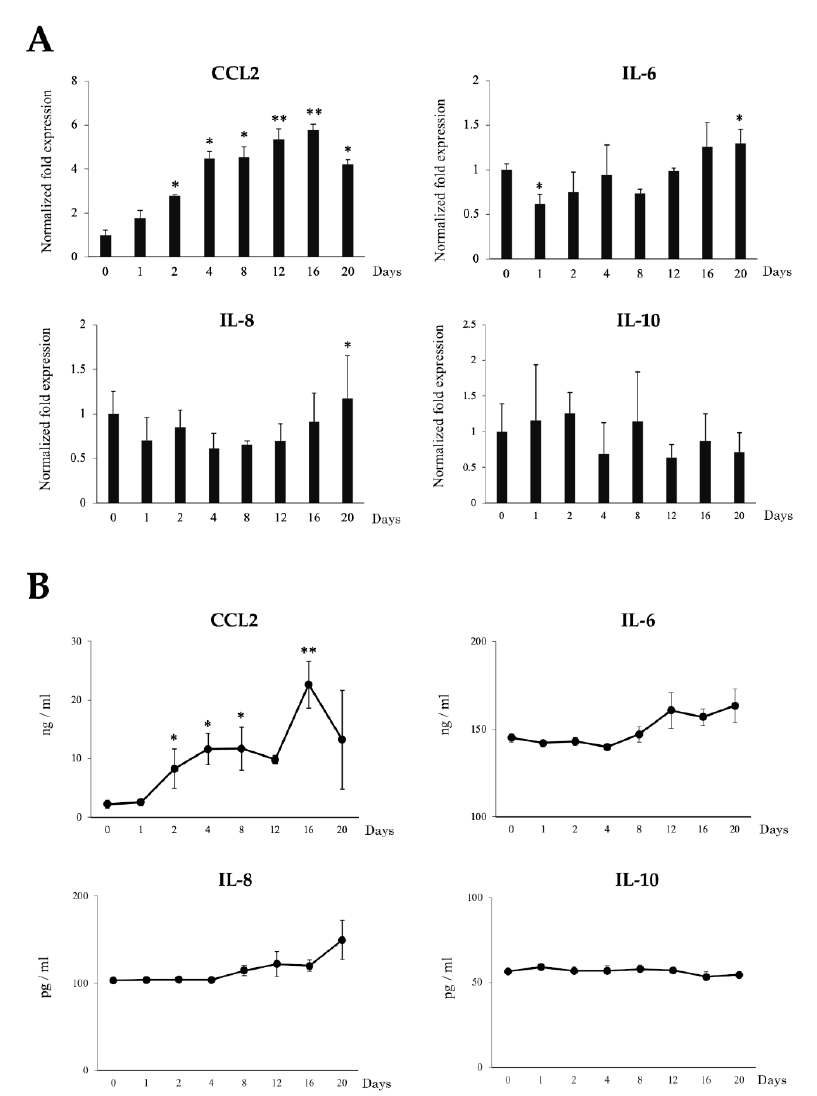
Figure 4. Long-term adipogenic di ff erentiation mediated expression dynamics of adipokines in the adipocytes without any exogenous inflammatory triggers. The mRNA expression ( A ) and protein concentration ( B ) of CCL2, IL-6, IL-8 and IL-10 in adipocytes over the 20 days of culture as measured by RT-qPCR and ELISA, respectively. Data shown are the mean ± SD of three independent experiments performed in triplicates. The asterisks: (*) and (**) indicated statistical di ff erences when compared with day 0 at the significance levels of p < 0.05 and p < 0.01, respectively.